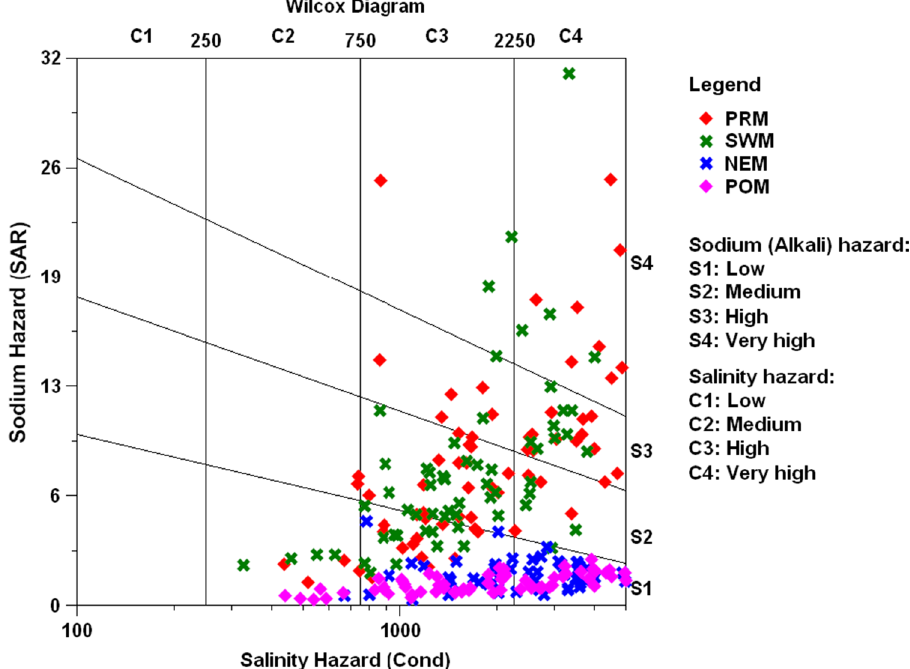
Fig. 5 USSL diagram